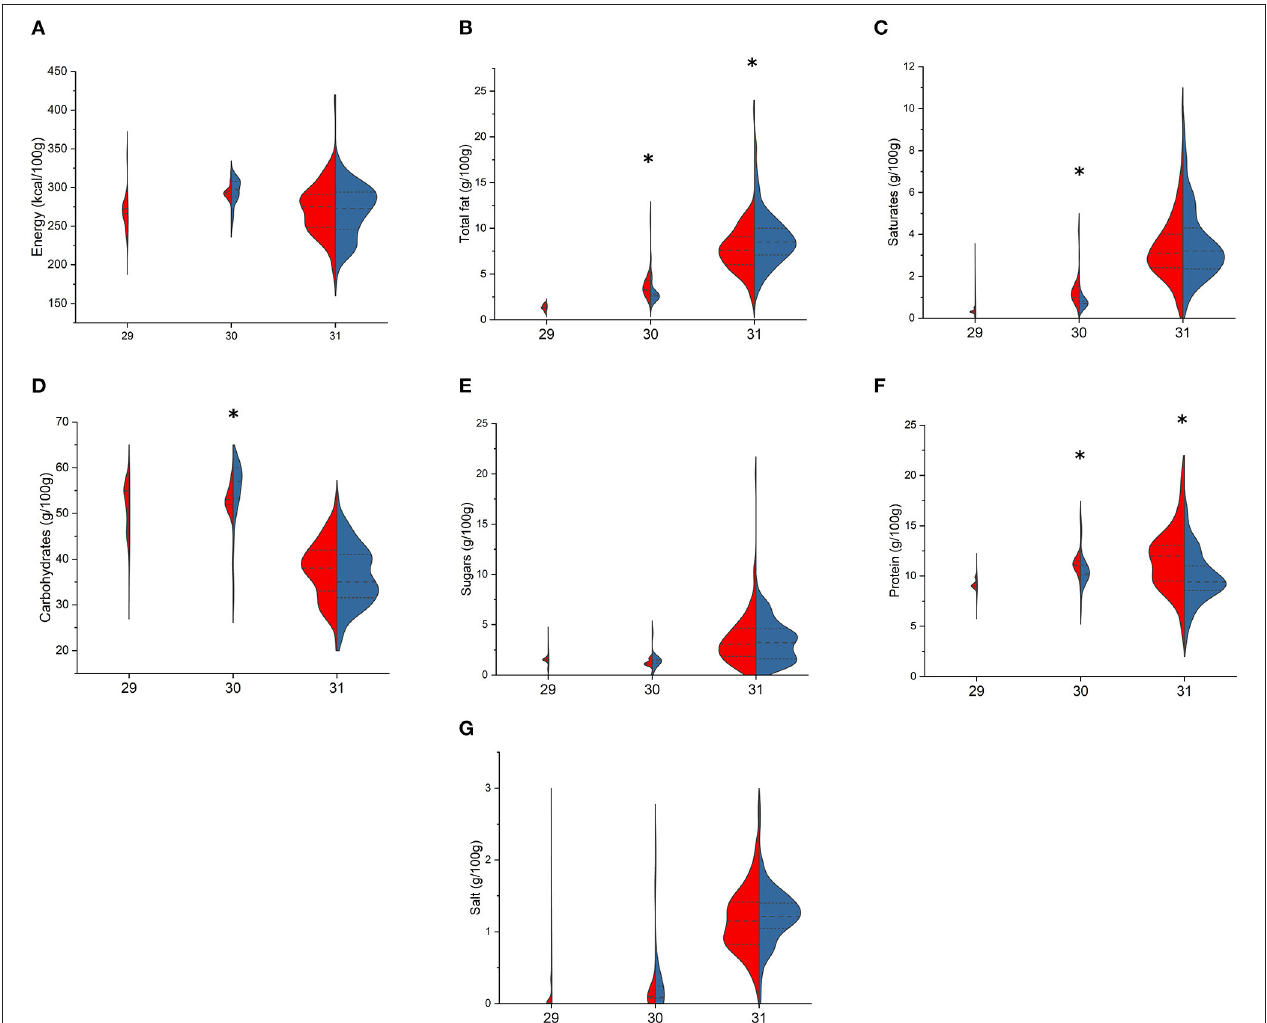
FIGURE 6 | Comparison of energy (A) , total fat (B) , saturates (C) , total carbohydrates (D) , sugars (E) , protein (F) , and salt (G) content in branded (BR, in blue) and private-label (PL, in red) types of fresh pasta. 29: semolina pasta; 30: egg pasta; 31: stuffed pasta. For each type, asterisk indicates significant difference between BR and PL items (Mann–Whitney non-parametric test for two independent samples), p <